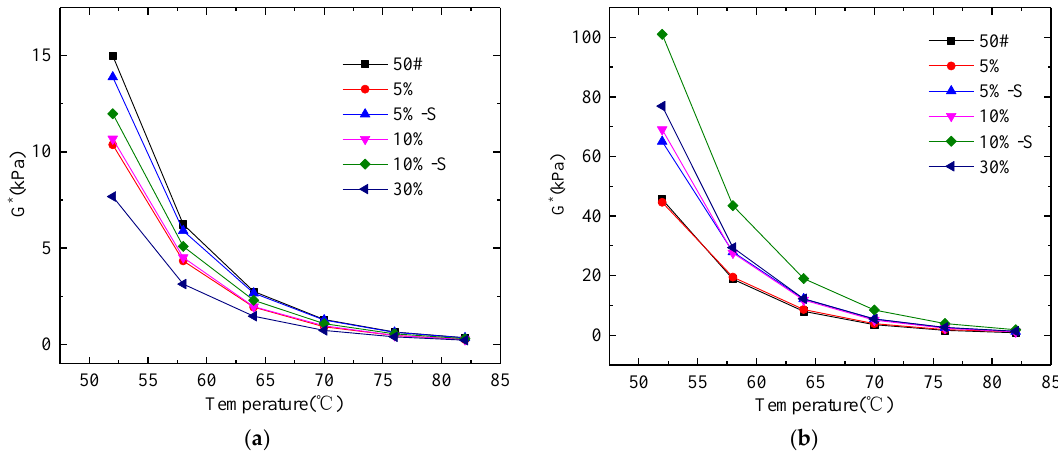
Figure 8. The relationship between complex modulus and temperature. ( a ) Unaged; ( b ) RTFO aged.